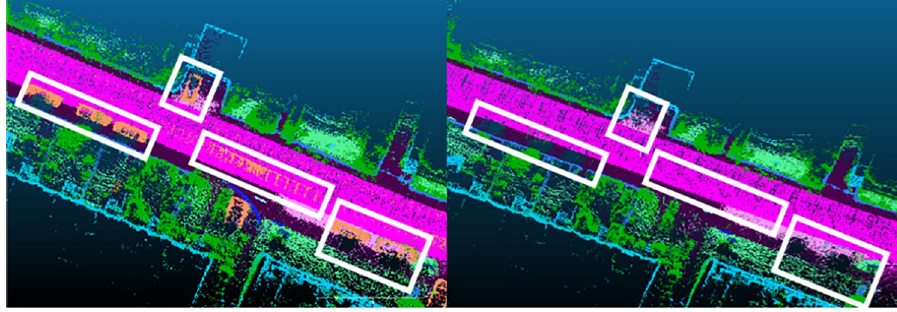
Fig 3. Visualization of dynamic object